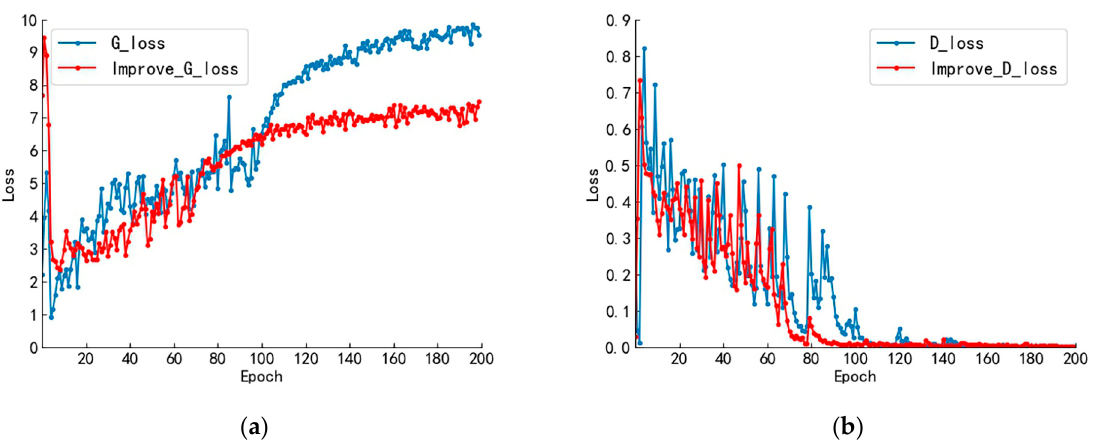
Figure 8. Comparison of DCGAN network loss function change curve before and after improvement: ( a ) comparison of generator loss function variation curves; and ( b ) comparison of discriminant loss function variation curves.